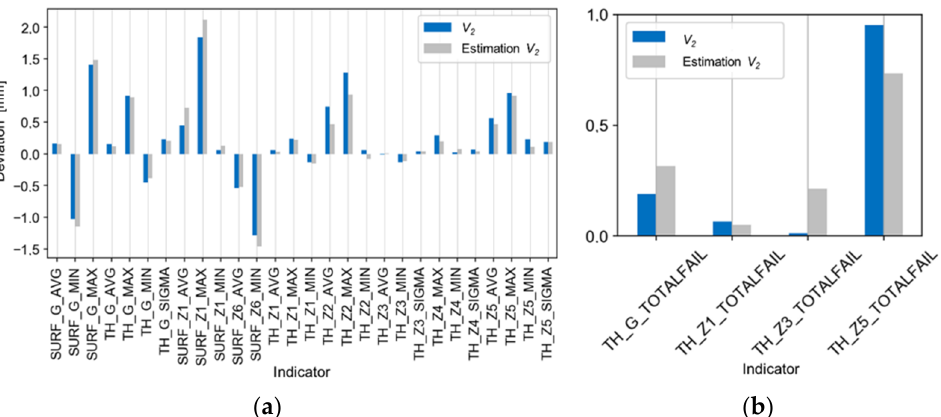
Figure 16. Comparison of the estimates of the results of the V2 trial (based on regression models) with the actual test results for the indicators of ( a ) deviations and of ( b ) tolerance.